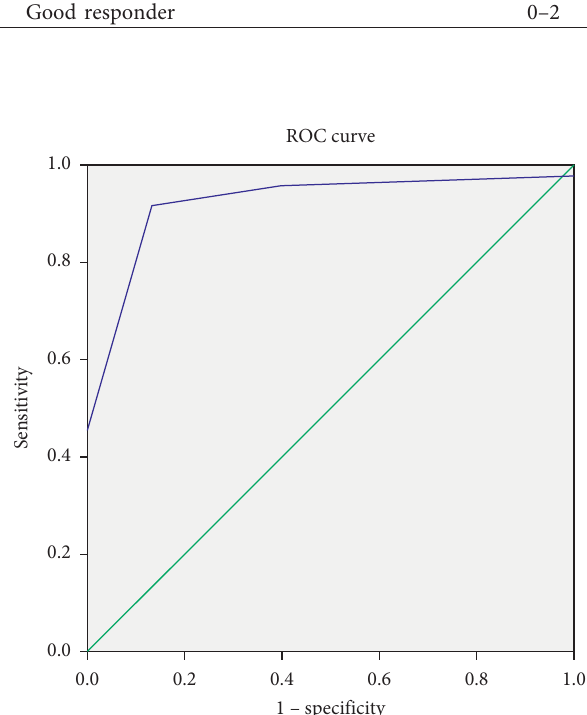
Figure 1: ROC curve. ROC curve in Section 3.3 showing a high value of sensitivity and specificity with larger area under the curve, and a steeper and sharper slope of the